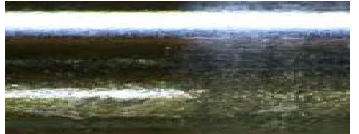
Fig. 5. Sediment on the bolt mushroom EGR valve in the co-operating zone with the guide sleeve.